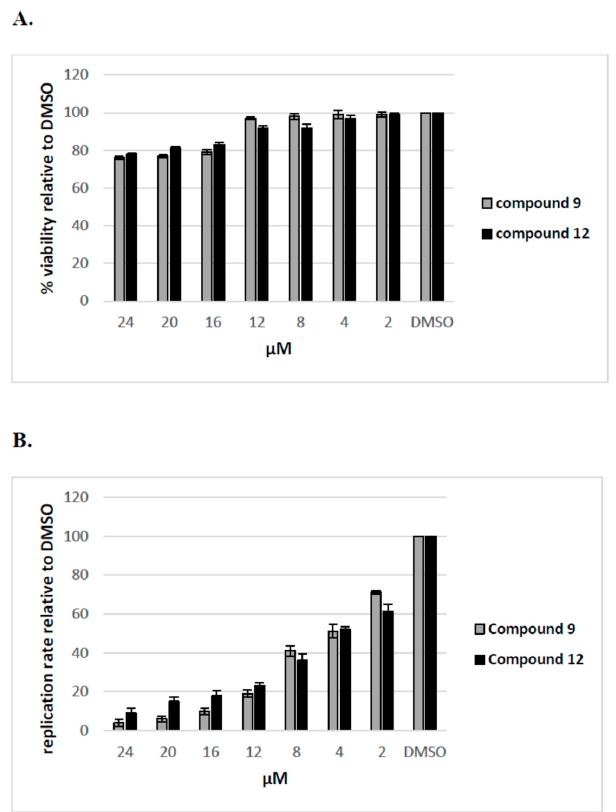
Figure 4. Antiviral effect of compounds 9 and 12 on viral replication. Huh7-J17 cells were plated in the presence of different doses of 9 and 12 , and 72 h later, cell viability was measured by MTT assay ( A ) or cells were lysed and antiviral effect was measured comparing luciferase activity ( B ). The values of compound-treated cells are expressed as percentage relative to DMSO-treated cells defined as 100% (control). Errors bars represent the S.D. of the means for 3 replicates.